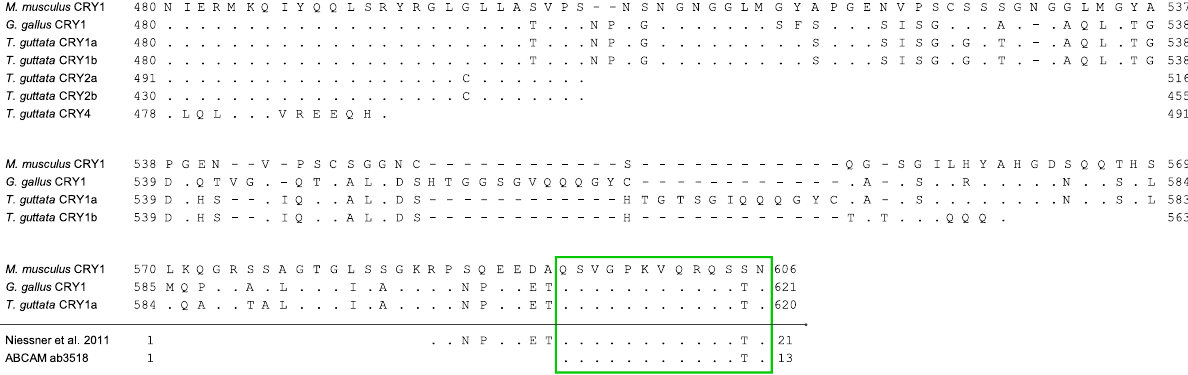
Figure 1. Alignment of the C-terminal amino acids of mouse ( Mus musculus ) CRY1 with chicken ( Gallus gallus ) CRY1 and several zebra finch ( Taeniopygia guttata ) cryptochromes. The green box highlights the target sequence detected by the ABCAM CRY1 antibody used in this paper, as well as the target sequence used by Niessner 26,27,56 , and Bolte 44 . Accession numbers: mouse CRY1 (NP_031797.1), chicken CRY1 (NP_989576.1), zebra finch CRY1a (XP_030118992.2), zebra finch CRY1b (XP_030118993.2), zebra finch CRY2a (XP_030130159.1), zebra finch CRY2b (XP_012429630.1), zebra finch CRY4